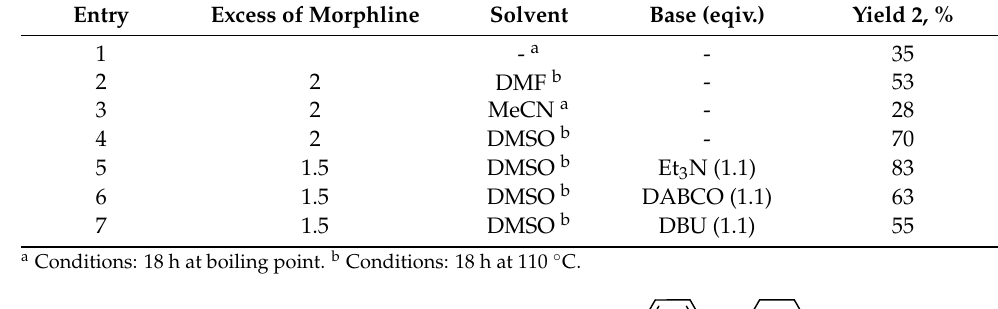
Table 1. Reaction of 4,7-dibromobenzo[ d ][1,2,3]thiadiazole 1 with morpholine. Entry Excess of Morphline Solvent Base (eqiv.) Yield 2, %